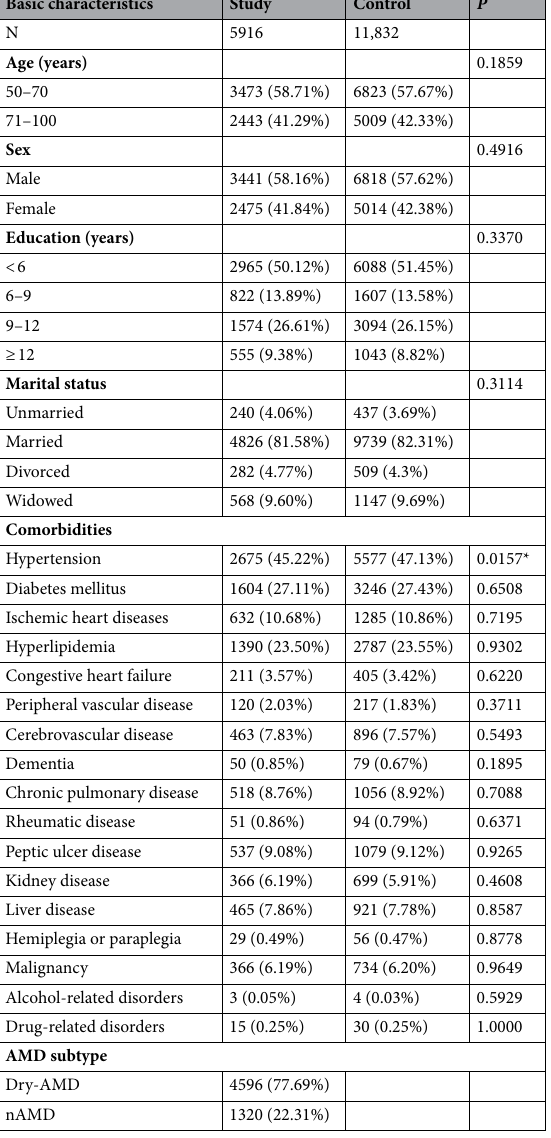
Table 1. Basic characteristics of the study and control groups. N number, AMD age-related macular degeneration, nAMD neovascular age-related macular degeneration. *Significant